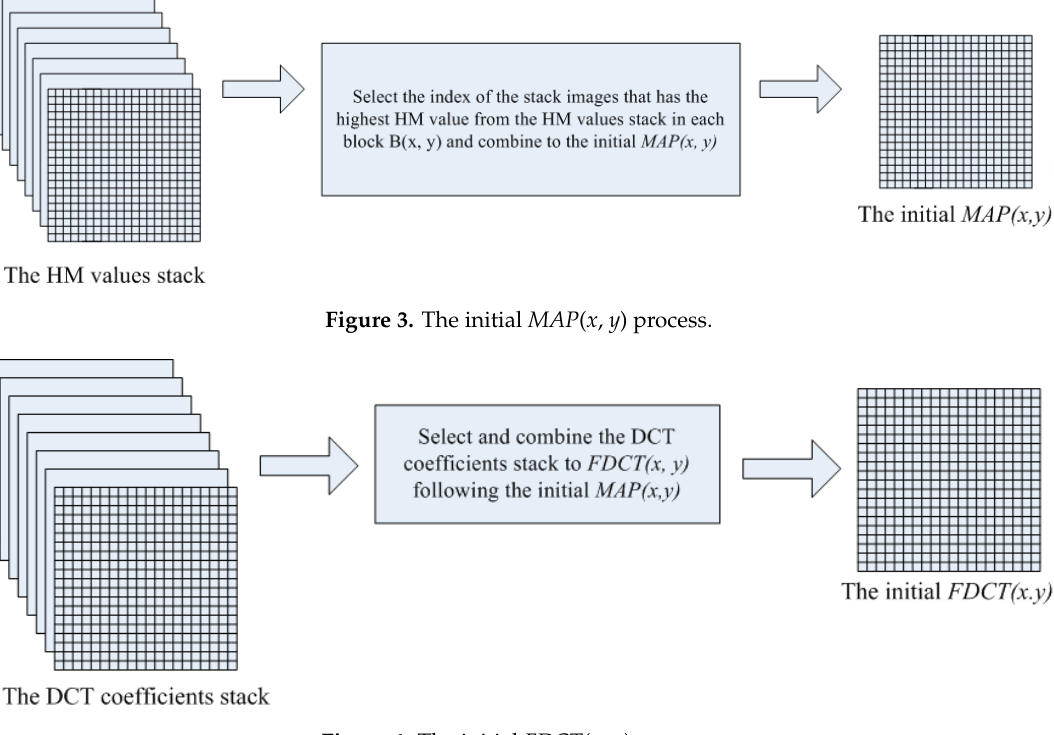
Figure 4. The initial FDCT ( x , y ) process.